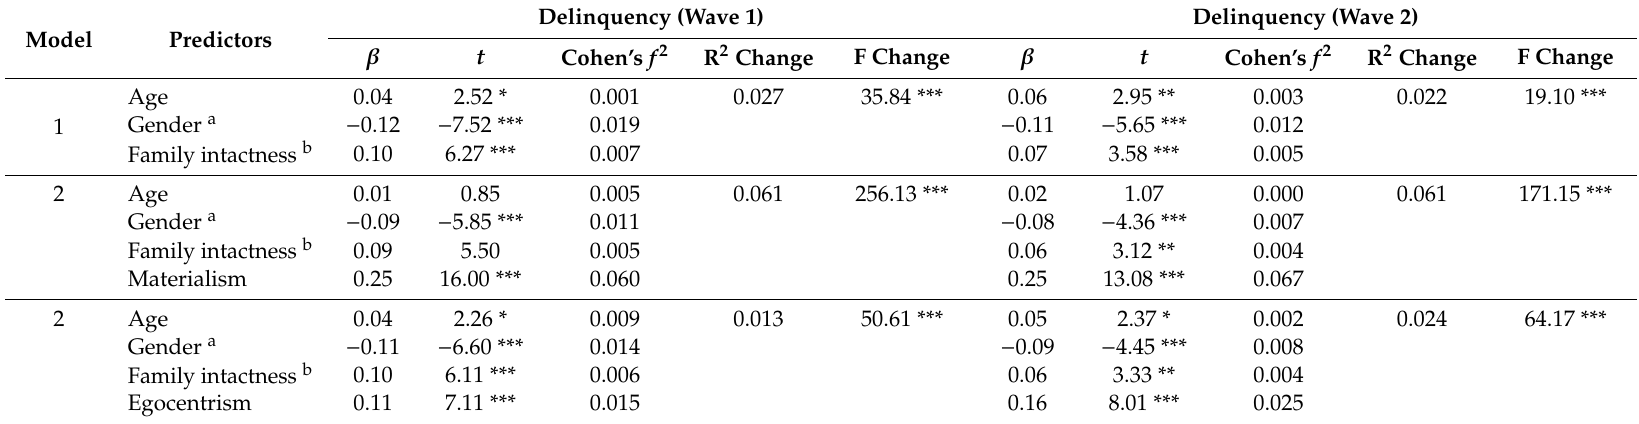
Table 3. Cross-sectional regression analyses for